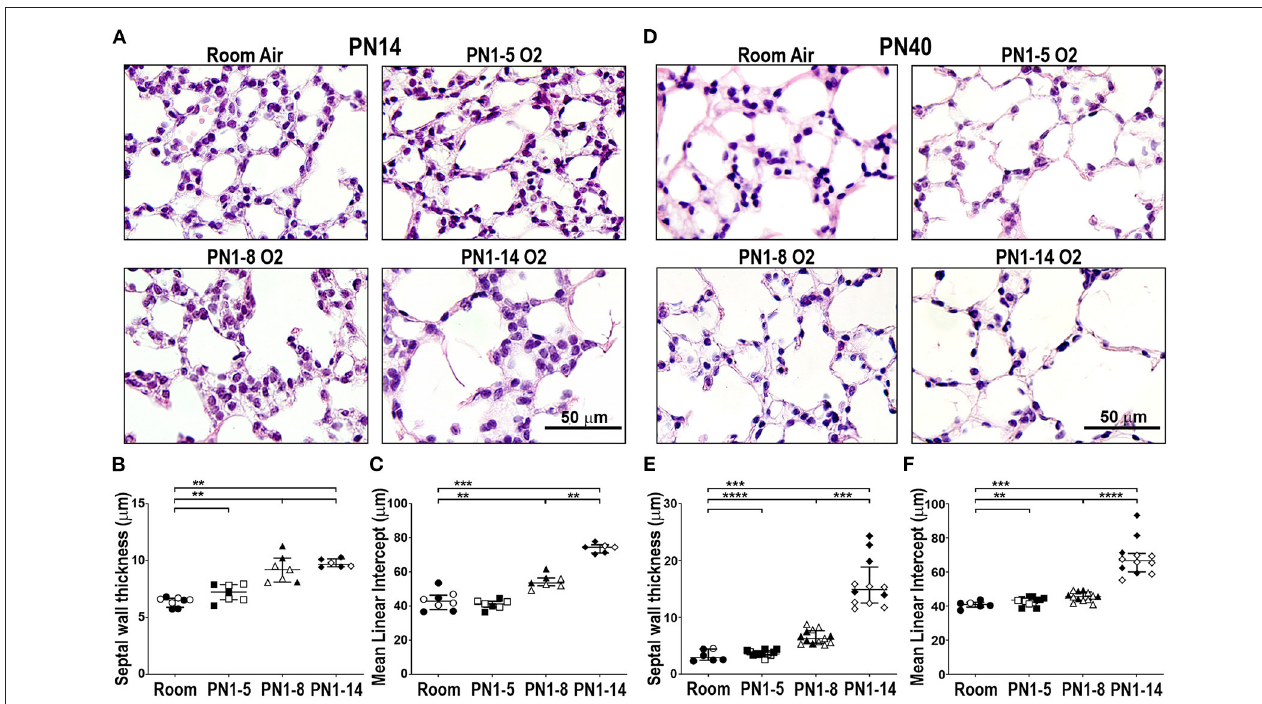
FIGURE 1 | Prolonged supplemental oxygen induces severe lung damage in neonatal mice that persists into young adulthood. C57BL/6 mice were housed in room air or treated from the day of birth with 75% O 2 for 5, 8, or 14 days, then analyzed at PN14 (A–C) or PN40 (D–F) . (A) Representative photomicrographs of H&E-stained lung cross-sections at PN14. (B) Median alveolar septal wall thickness of mice in (A) . (C) Alveolar airspace size by mean linear intercept length ( µ m) of mice in (A) . (D) Representative photomicrographs of H&E-stained lung cross-sections at PN40. (E) Median alveolar septal wall thickness of mice in (D) . (F) Alveolar airspace size by mean linear intercept length ( µ m) of mice in (D) . Images in (A) and (D) were taken using a 40x objective using an Olympus BX-51 bright field microscope. Scale bar = 50 µ m. For (B,C,E,F) , data is median ( µ m) ± IQR. ** P < 0.01, *** P < 0.001, **** P < 0.0001 by Mann-Whitney U -test (2-tailed). n ≥ 6